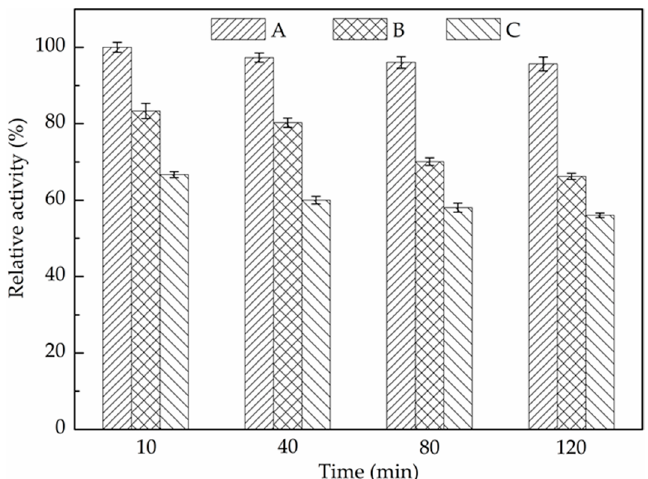
Figure 8. Inhibitory effect of 2-MT on CAT activity. Conditions: CAT: 1.0 × 10 − 6 mol·L − 1 ; 2-MT: 0 mol·L − 1 (A); 3 × 10 − 5 mol·L − 1 (B); 1 × 10 − 4 mol·L − 1 (C); pH 7.4, T = 291 K.